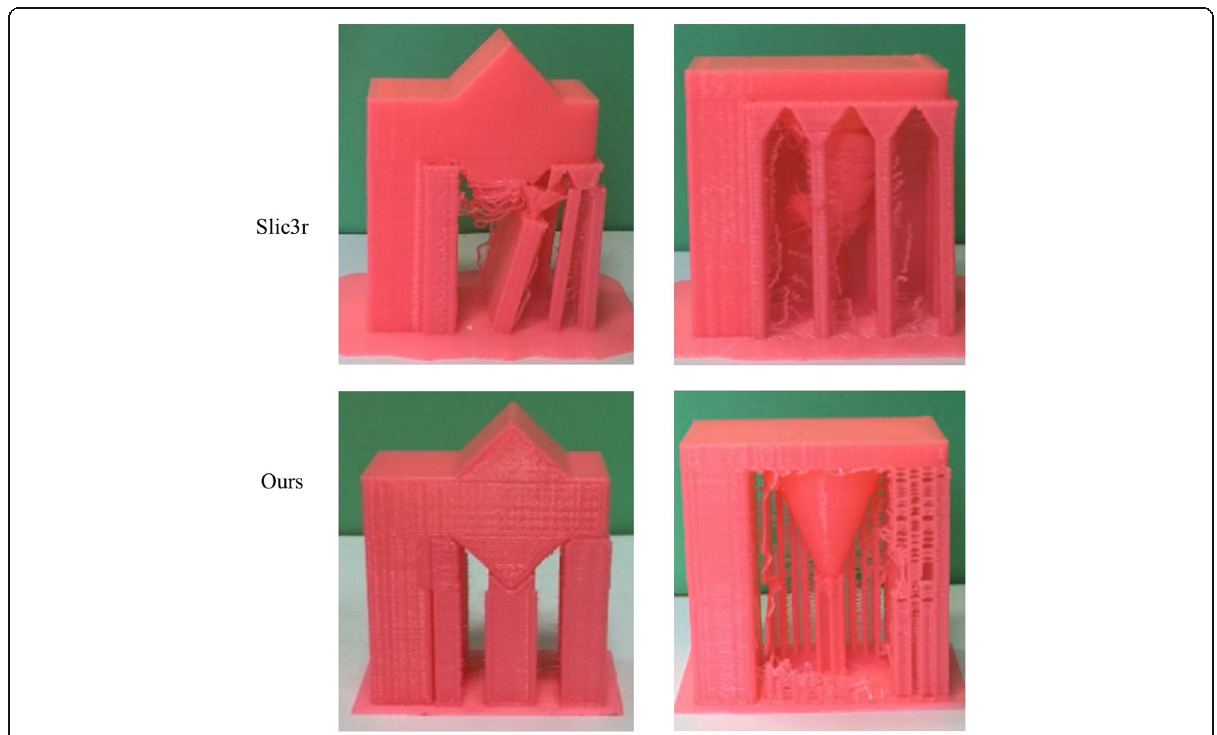
Fig. 9 Print result of supporting structure generation with different